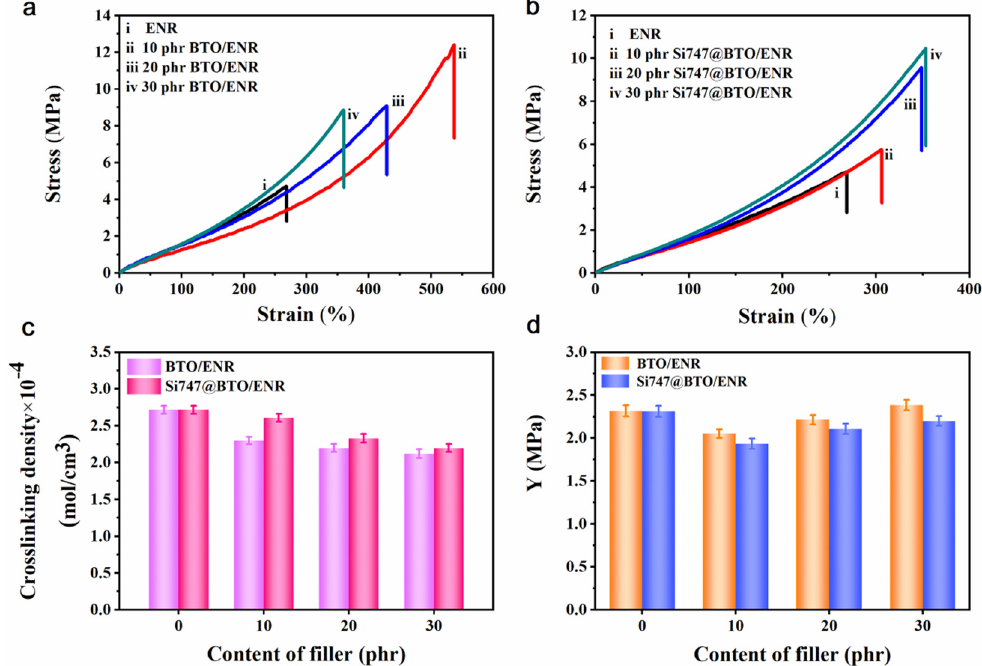
Figure 4. Typical stress–strain curves of ENR composites. ( a ) BTO/ENR and ( b ) Si747@BTO/ENR composites. ( c ) Crosslinking density, and ( d ) Y values of BTO/ENR and Si747@BTO/ENR composites.